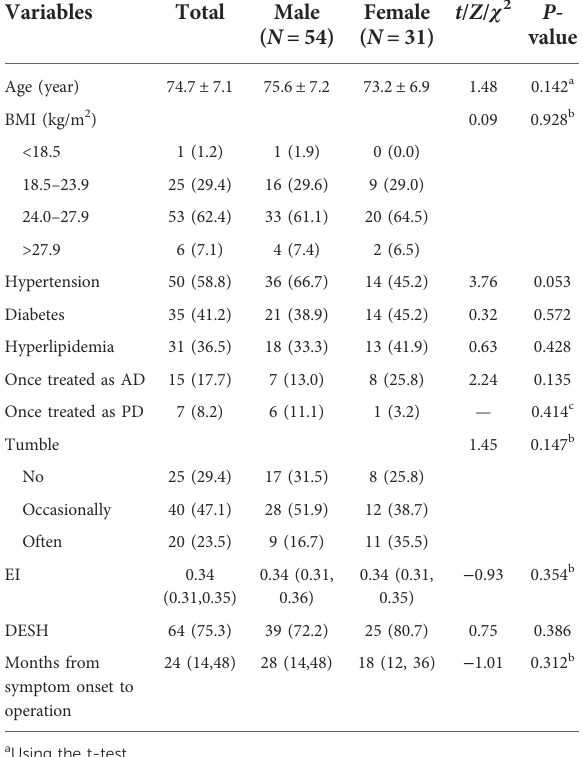
TABLE 1 Basic characteristics of research